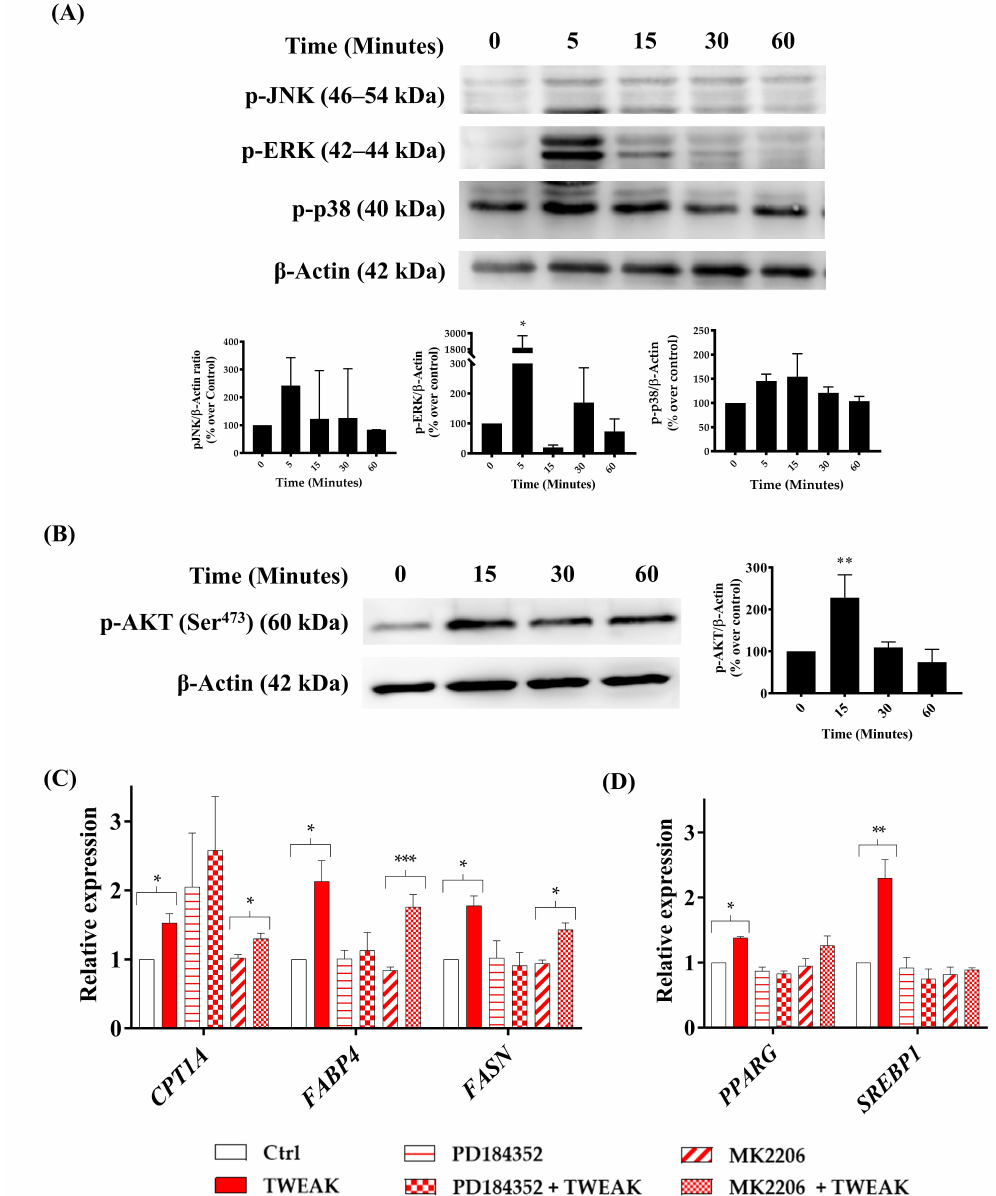
Figure 5. sTWEAK phosphorylates ERK1/2 and AKT(ser473) and regulates lipid-related gene expression in PC-3 cells. Cells were stimulated with 100 ng/mL sTWEAK at different time points. ( A ) MAPK and ( B ) AKT (ser473) phosphorylation were analyzed by Western blotting. Representative Western blots and a densitometry analysis of 3 independent experiments (mean ± SEM) are shown. * p < 0.05 and ** p < 0.01. PC-3 cells were treated with 10 µ M ERK1/2 inhibitor (PD184352) or 1 µ M AKT inhibitor (MK2206) and then stimulated with 100 ng/mL sTWEAK for 24 h. The gene expression of the ( C ) CPT1A , FABP4 and FASN and ( D ) PPARG and SREBP1 transcription factors were evaluated by RT-qPCR. The relative gene expression levels are shown normalized to their corresponding untreated controls. Data are expressed as the mean ± SEM ( n = 4 experiments). Significant differences: * p < 0.05, ** p < 0.01 and *** p < 0.001. Detailed information about the Western blotting can be found in Figure S6. Abbreviations: p-JNK, phospho-Jun N-terminal Kinase; p-ERK, phospho-extracellular signal-regulated kinase, p-p38, phospho- p38 mitogen-activated protein kinase, p-AKT, phospho- Protein kinase B; β -Actin, beta-actin; CPT1A, Carnitine palmitoyltransferase IA; FABP4, fatty acid-binding protein 4; FASN, Fatty acid synthase; SREBP1, Sterol regulatory element-binding transcription factor 1; PPARG, Peroxisome proliferator-activated receptor gamma; % over control: values are calculated as percentage over untreated cells at time 0; kDa, Kilodaltons: RT-qPCR, reverse transcription quantitative